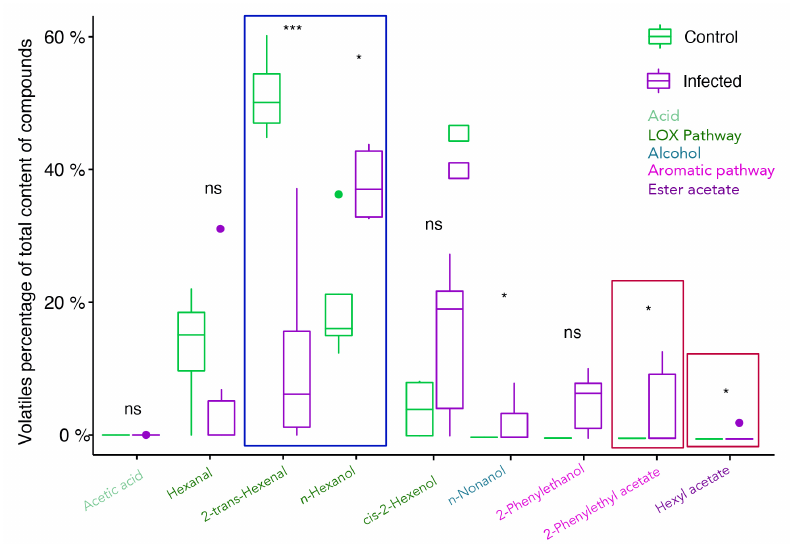
Figure 4. Evaluation of free volatile organic compounds in V. vinifera cv. Trincadeira grapes at the harvest stage (EL38) (mock and B. cinerea infected). Sample quantities were normalised for the percentage of total content of compounds (total compounds not shown). Box-and-whisker plots rep- resent the minimum, first quartile, sample median, third quartile, maximum, and outliers. Data were analysed with the t-test or Wilcoxon–Mann–Whitney test depending on non-parametric/parametric distribution. Asterisks indicate significant differences between control and infected samples within